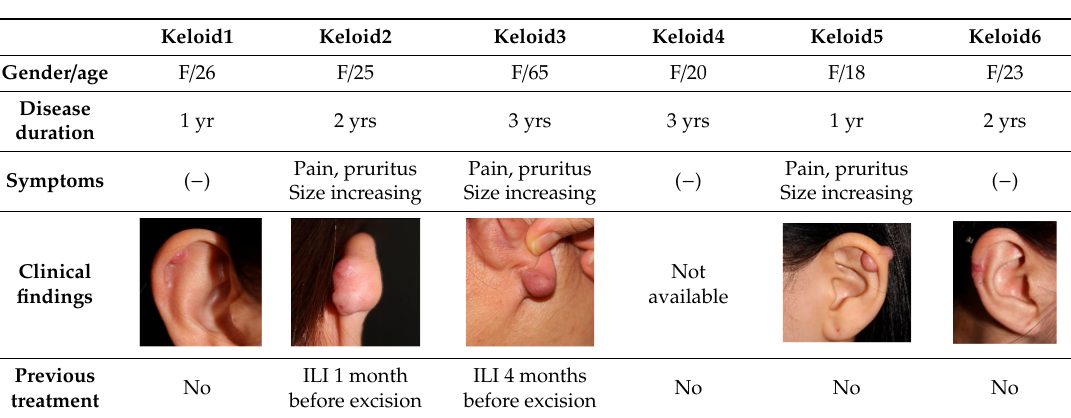
Table 1. Clinical characteristics of patients with